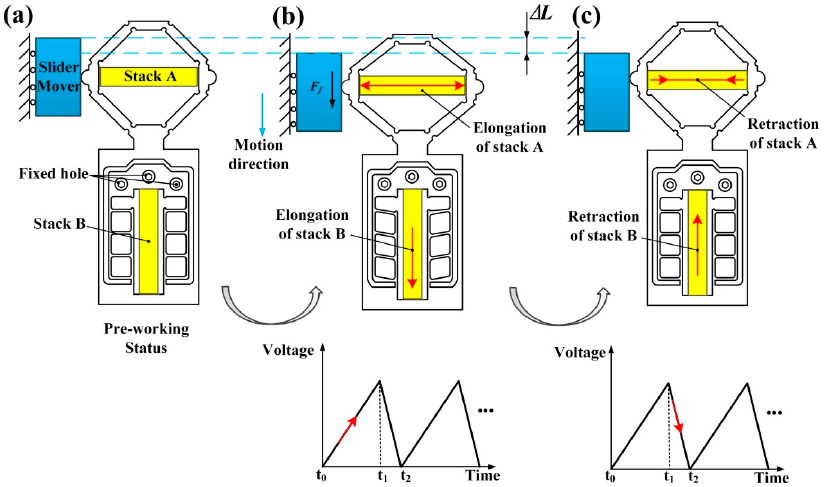
Figure 3. Working process of a circle: ( a ) the initial position; ( b ) the largest displacement position; and ( c ) the final position.